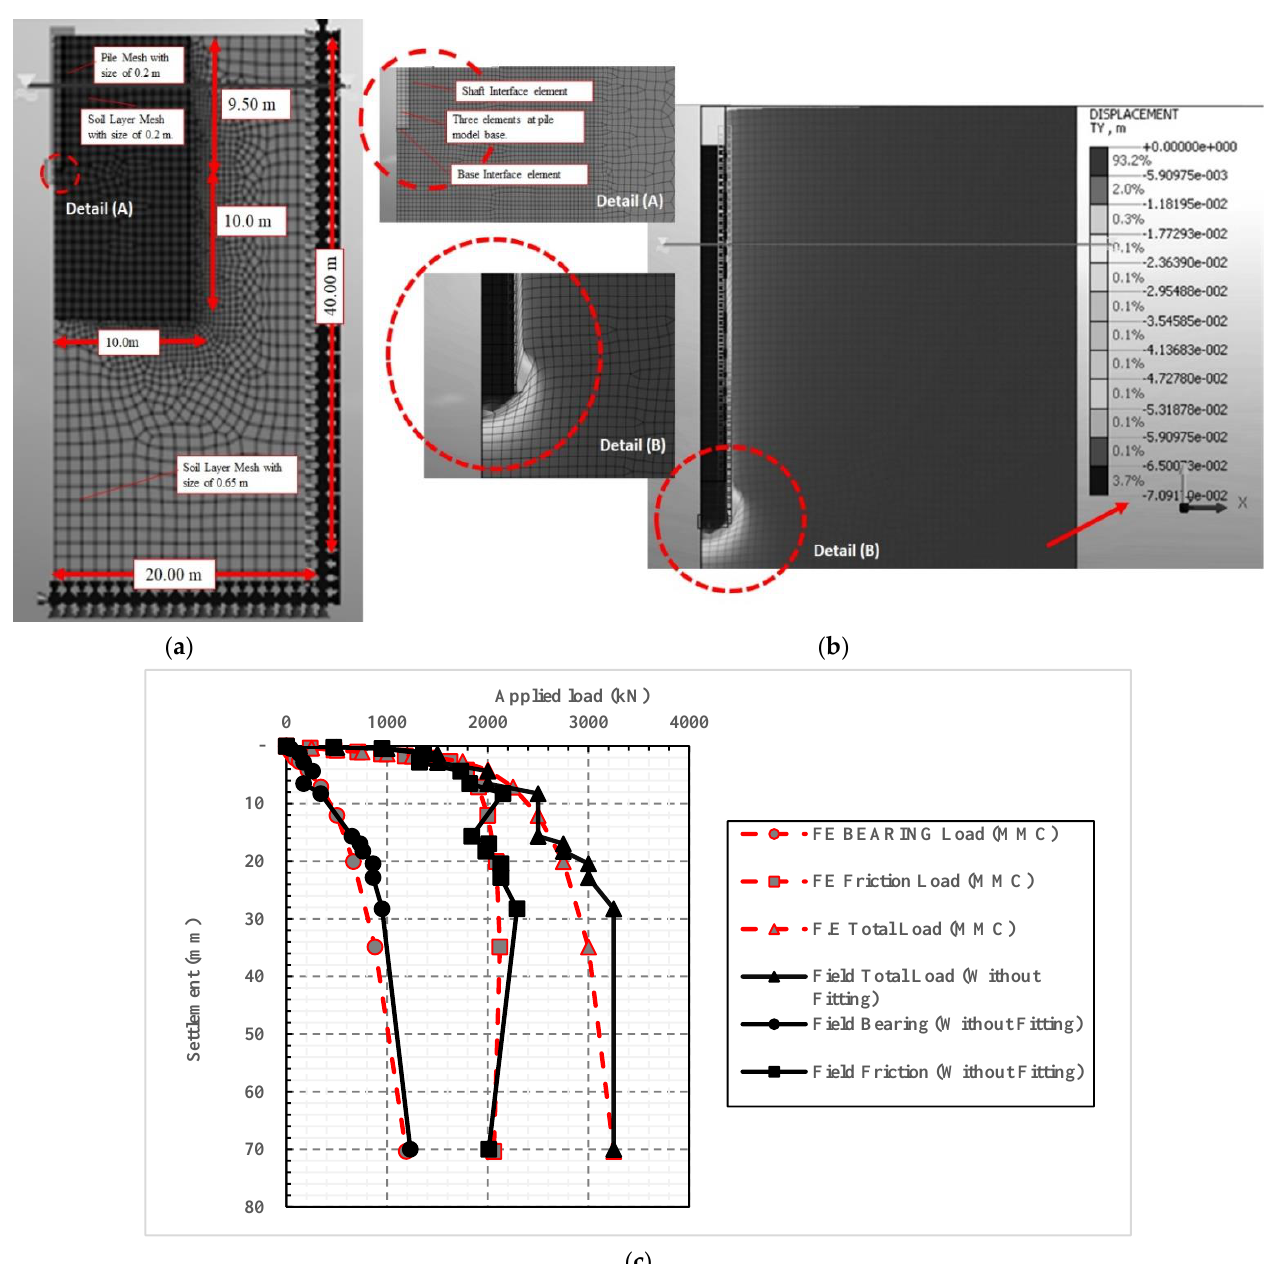
Figure 2. Numerical model established to simulate the response of the LDBP of the Alzey bridge case history (after [39]). ( a ) Details of boundary conditions. ( b ) Deformed shape of the finite element mesh (MMC) under the failure load. ( c ) Com- parison between field measurements and the numerical results (after [39]).